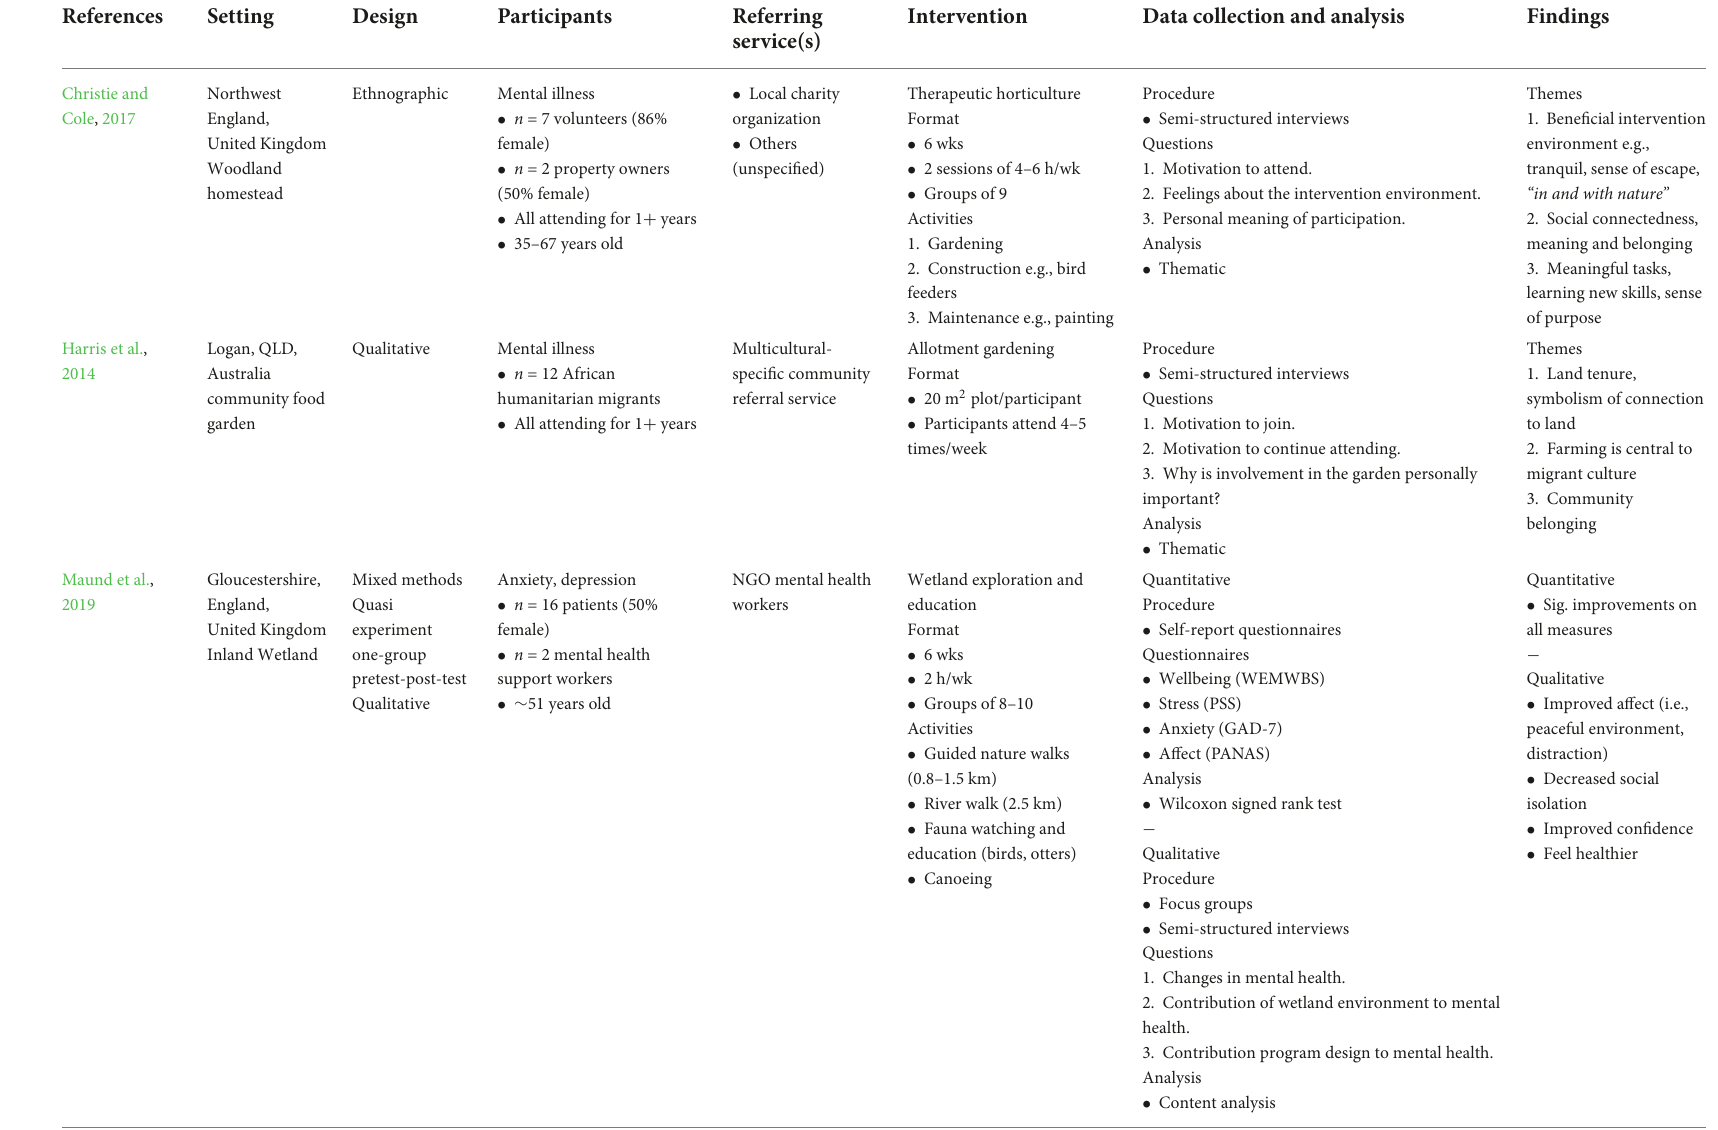
TABLE 3 Study methods and results